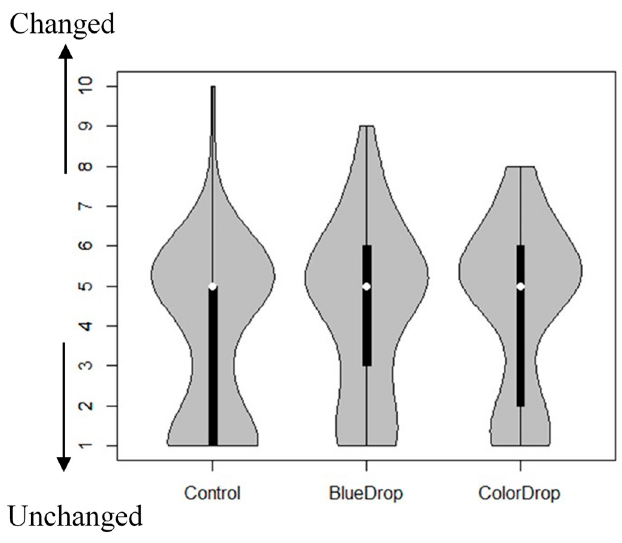
Figure 5. Distribution of answers to the question about the change in water usage (‘How much do you think that your water usage has changed?’).